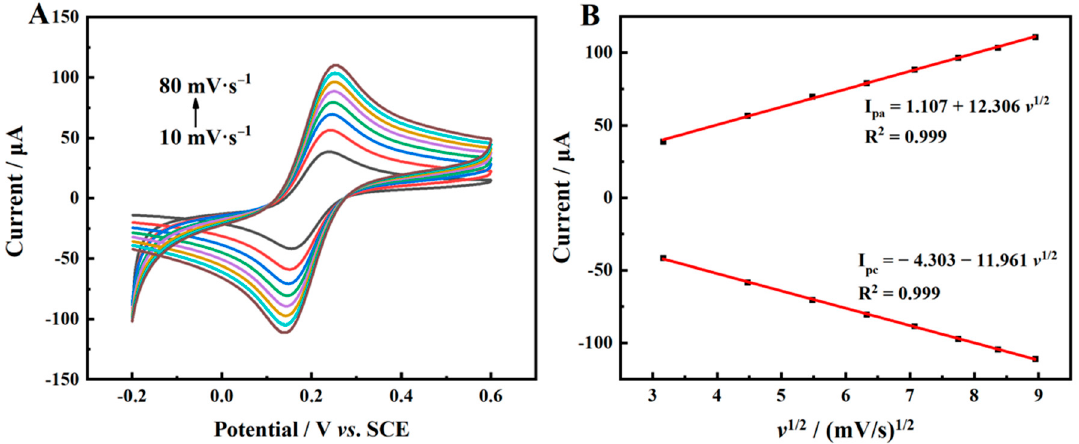
Figure 3. ( A ) CV responses of TiO 2 -MXene/PEDOT:PSS/GCE in 5 mM of [Fe(CN) 6 ] 3 − /4 − solution con- taining 0.1 M of KCl at di ff erent scan rates; ( B ) The linear relationship between the peak current and v 1/2 .